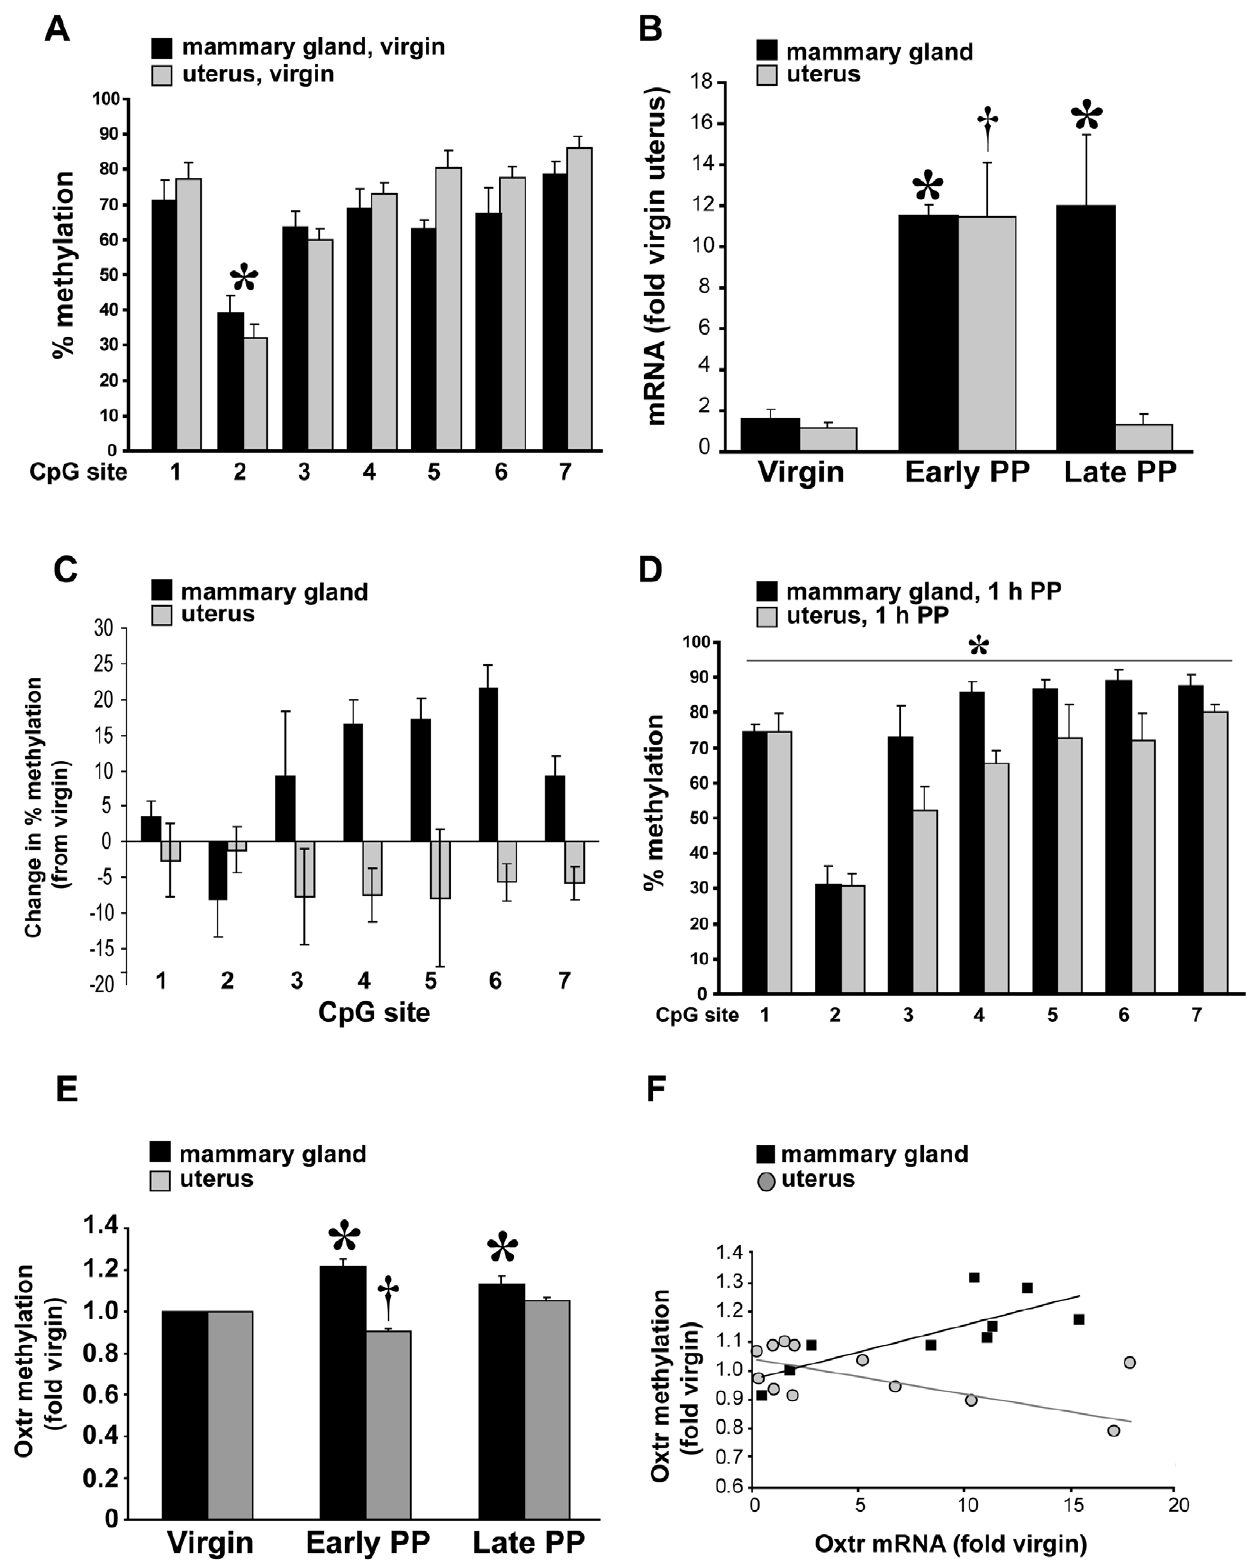
Figure 5. Oxtr promoter methylation changes invivo . A ) The methylation pattern of the Oxtr promoter shows no significant difference between the mammary glands (black bars, n=3) and uterus (gray bars, n=4) of virgin mice. Nevertheless, a significant difference in methylation was found between CpG sites among all animals. B ) Oxtr mRNA levels in the mammary glands (black bars, n=4) and uterus (gray bars, n=5) are significantly elevated 1 h following parturition (early postpartum). Whereas in the uterus mRNA levels dropto background 24 h later (late